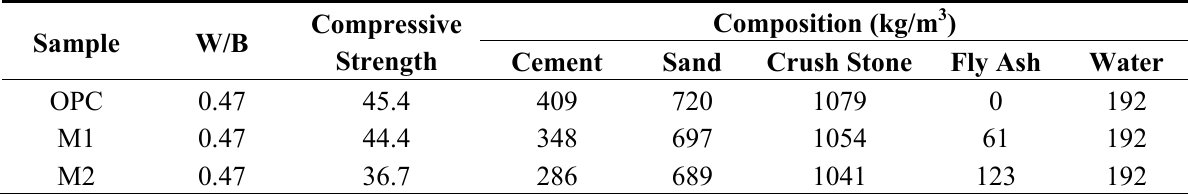
Table 2. The physical characterizations and mix proportions of all